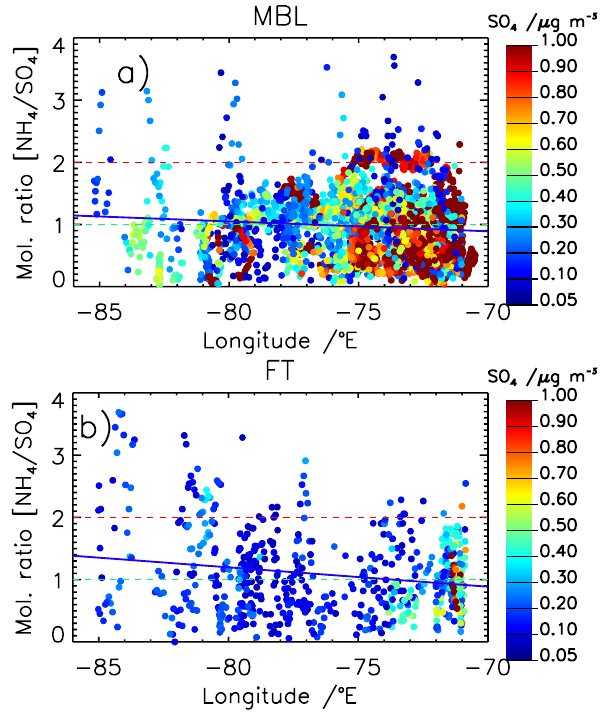
Fig. 9. Ammonium to sulphate molar mass ratio plotted as a func- tion of longitude below 1200m altitude (left panel) and between 1700m and 3200m (right panel). A dashed green line defines a mo- lar ratio of unity and red a ratio of 2.